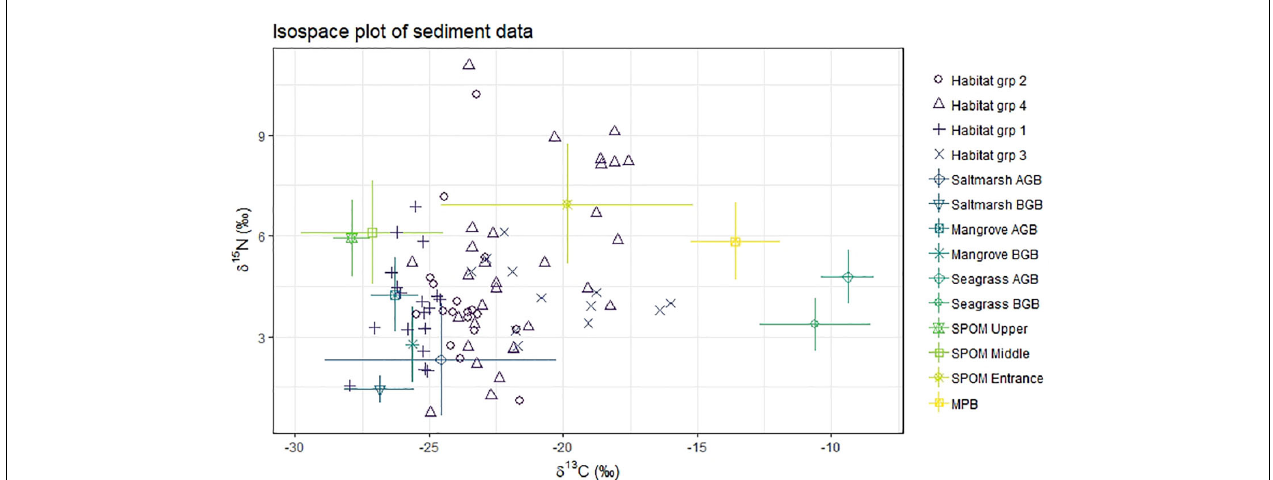
FIGURE 5 | Isospace of sediment samples and potential sources isotopic signatures ( δ 13 C Mangrove; 3, Seagrass; 4, Unvegetated. AGB, above ground biomass; BGB, below ground biomass; MPB, microphytobenthos; SPOM, suspended particulate